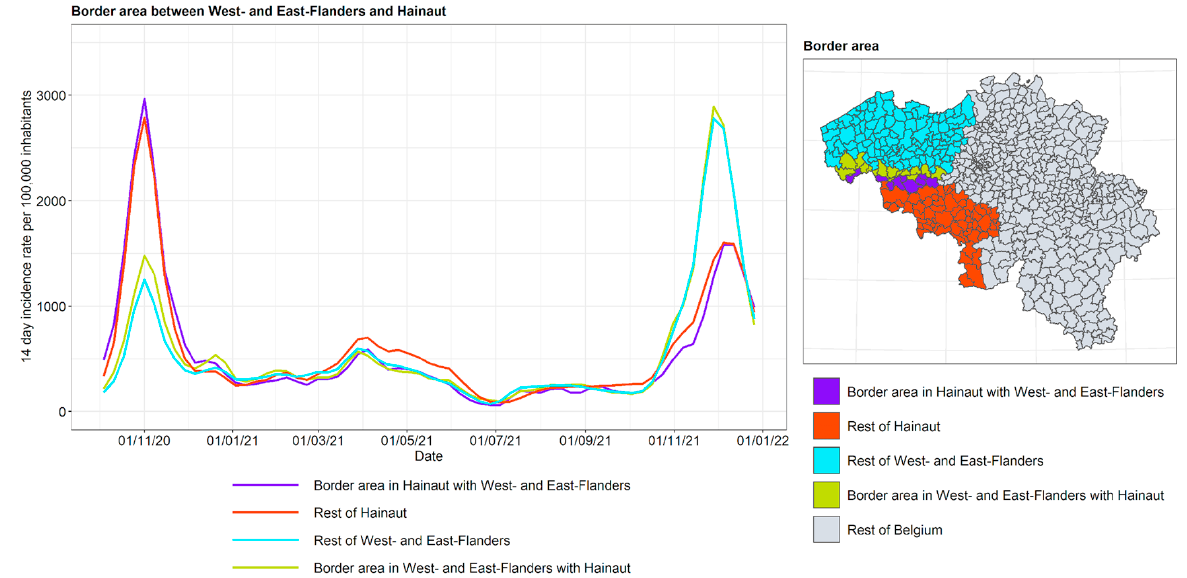
Figure 18. COVID-19 incidence curves for intranational language border between Hainaut and West and East Flanders.